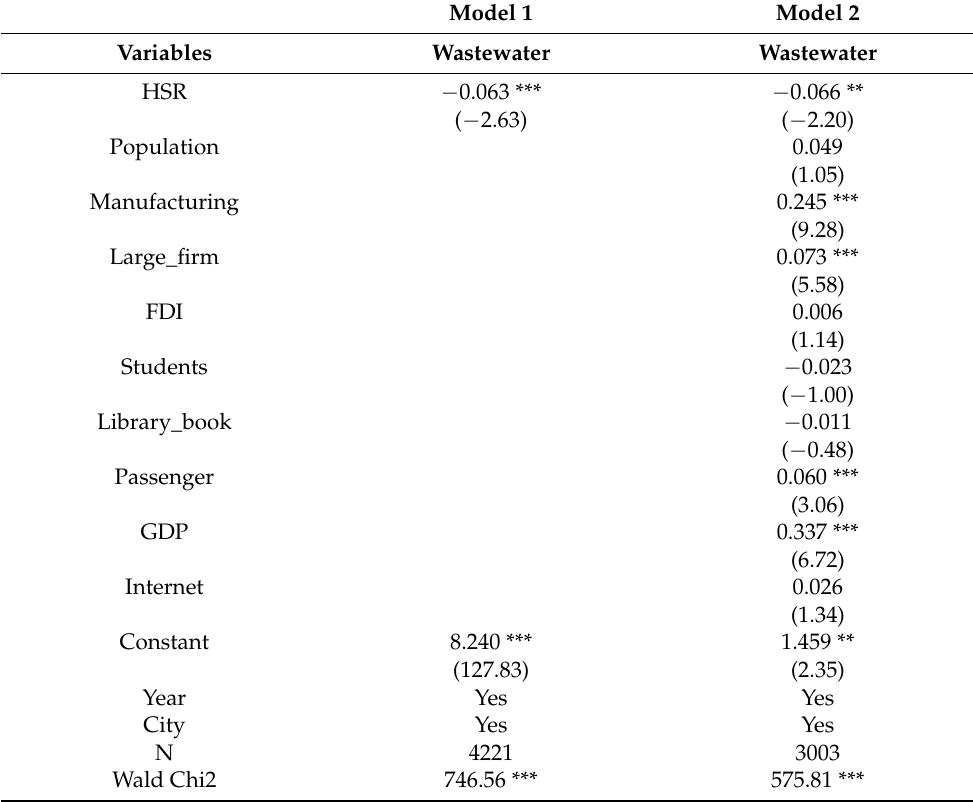
Table 3. The baseline regression methods of the time-varying DID